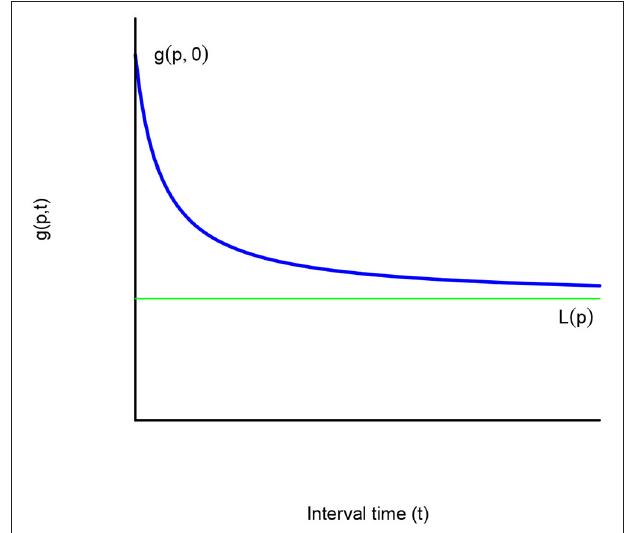
FIGURE 3 | A singular discount function. Source: own